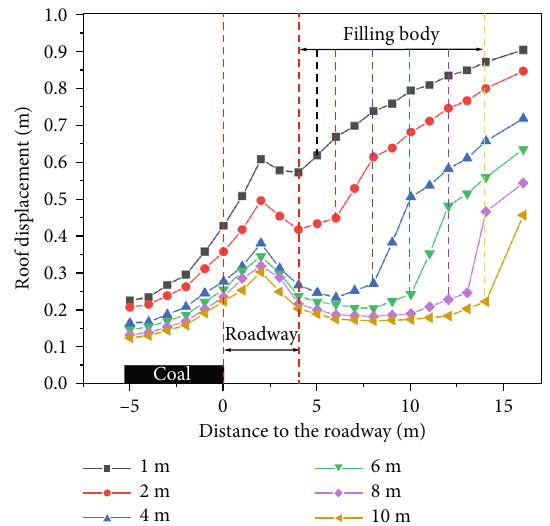
Figure 7: Vertical displacement distribution of the fi lling body with di ff erent widths behind the working